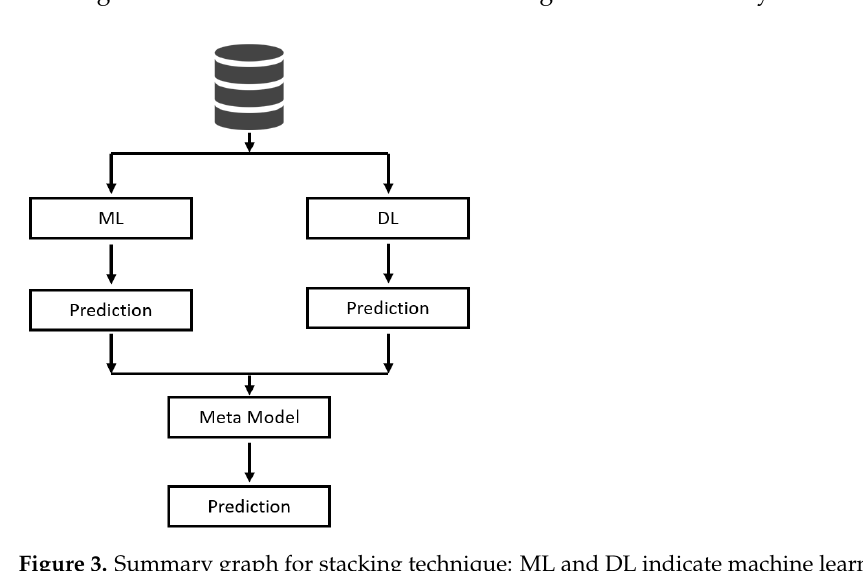
Figure 3. Summary graph for stacking technique: ML and DL indicate machine learning and deep learning, respectively.